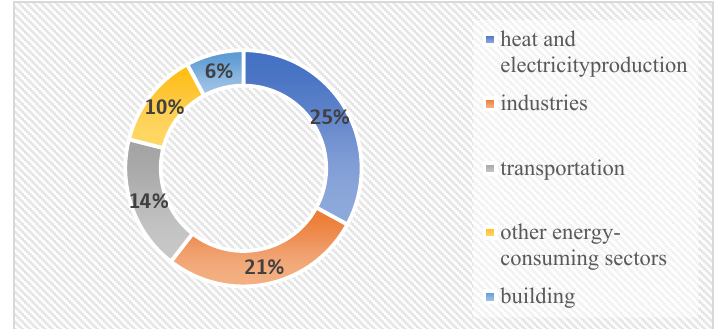
Figure 1. Major contributors to greenhouse gas (GHG) emissions [16] .